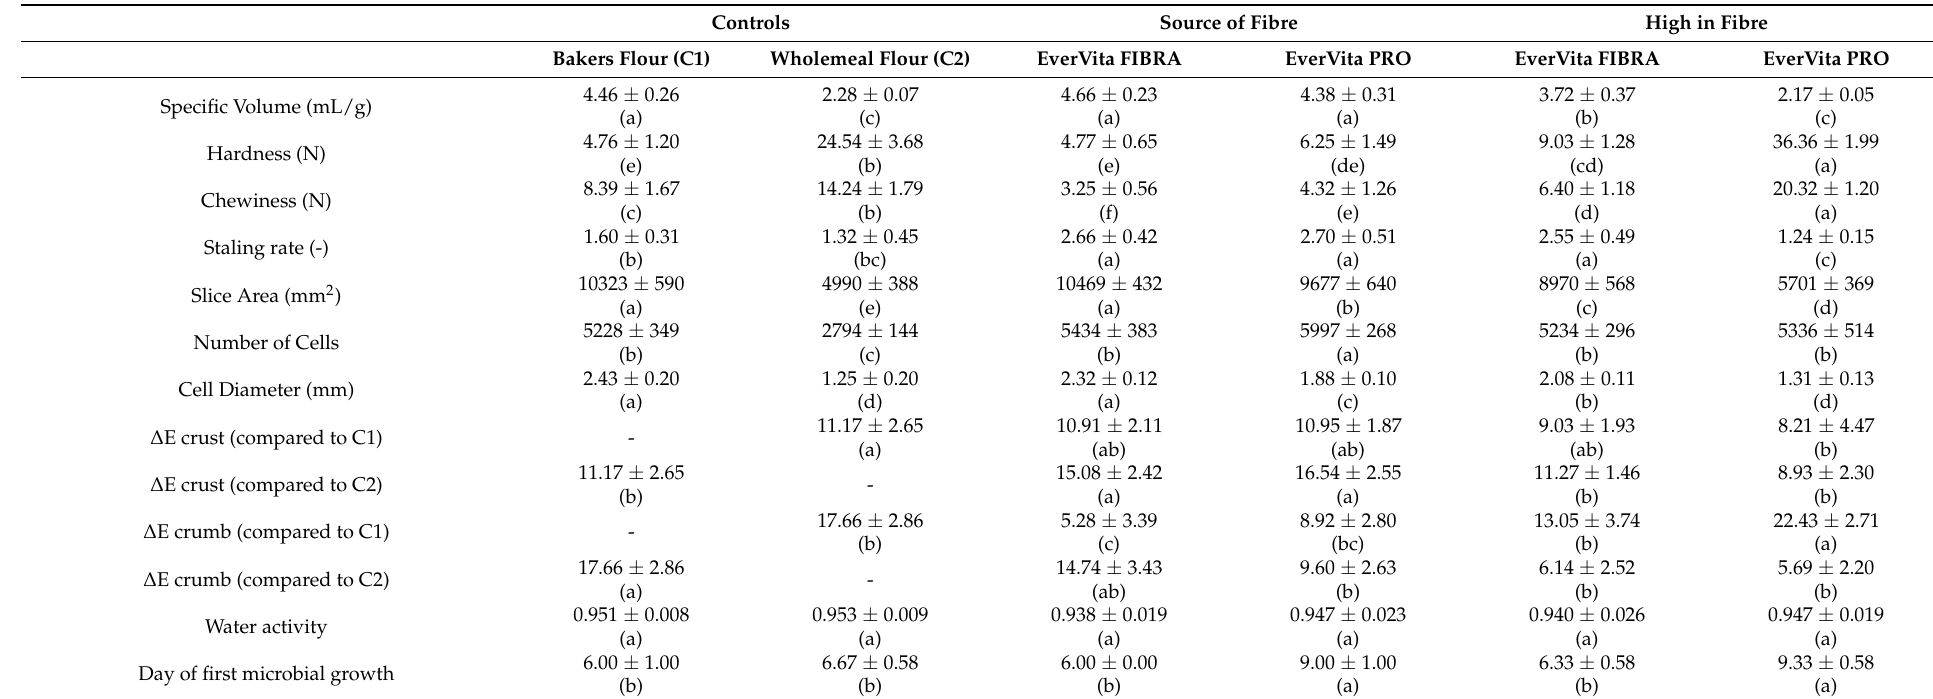
Table 3. Technological properties of the bread samples. The results show mean values ± standard deviations. Values with the same lower-case letter in a row do not differ significantly from each